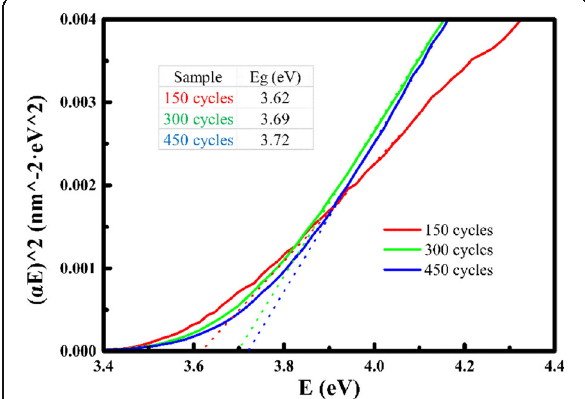
Fig. 2 The band gap (Eg) of AZO films by linear extrapolation, where α is the absorption coefficient ( α =4 π k / λ ) and E is the photon